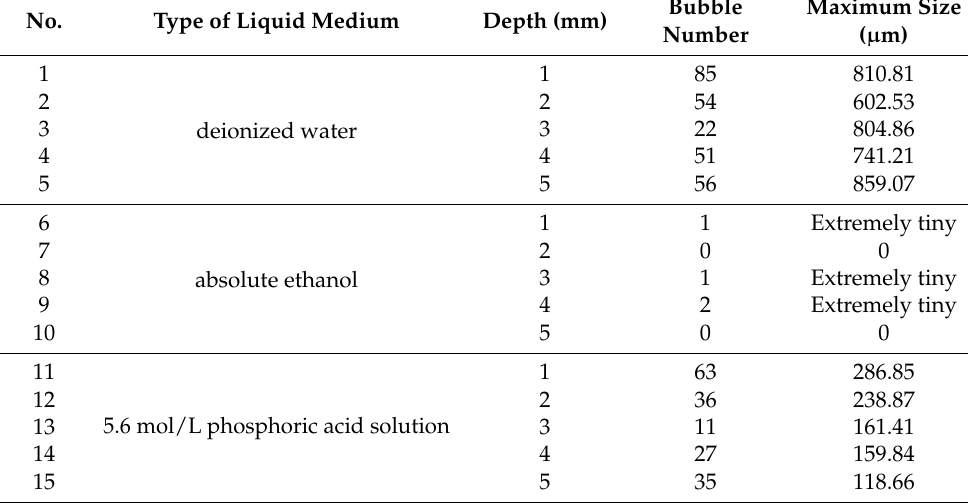
Table 1. Experimental